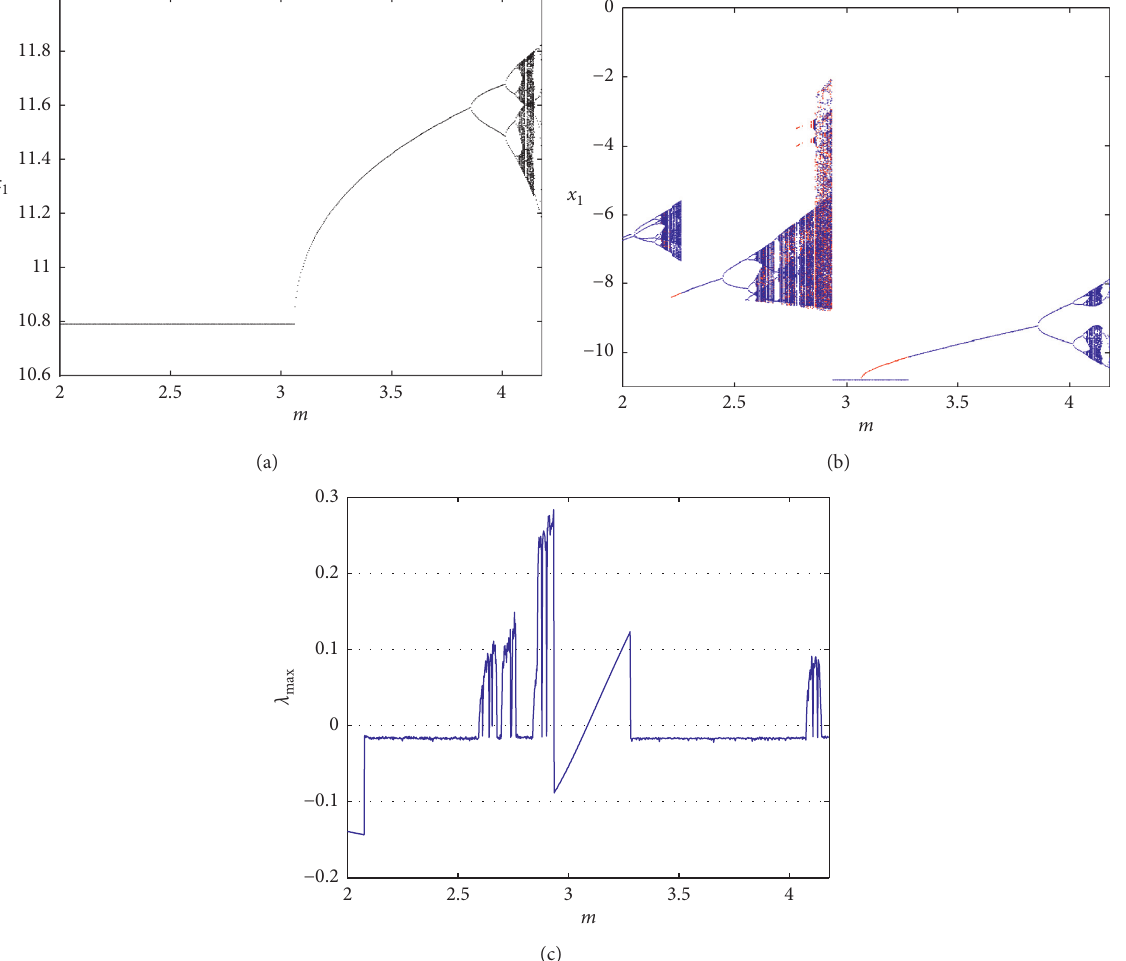
Figure 11: (a, b) Bifurcation diagrams showing local maxima of the coordinate x ) plotted in the range 2 ≤ m ≤ 4 . 18, with a � 1 . 8, b � 3 . 8, c � 2 . 442, and d � 1 . 35. Lyapunov exponent ( λ max